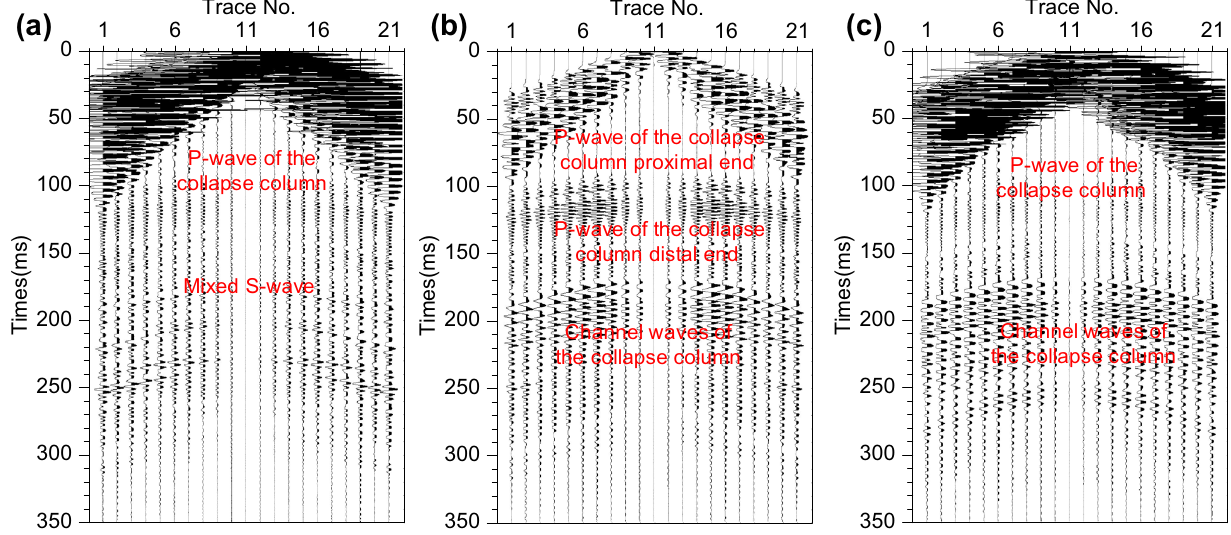
Fig. 7 Synthetic three-component records of the model (Source No. 11): a X component, b Y component, c Z